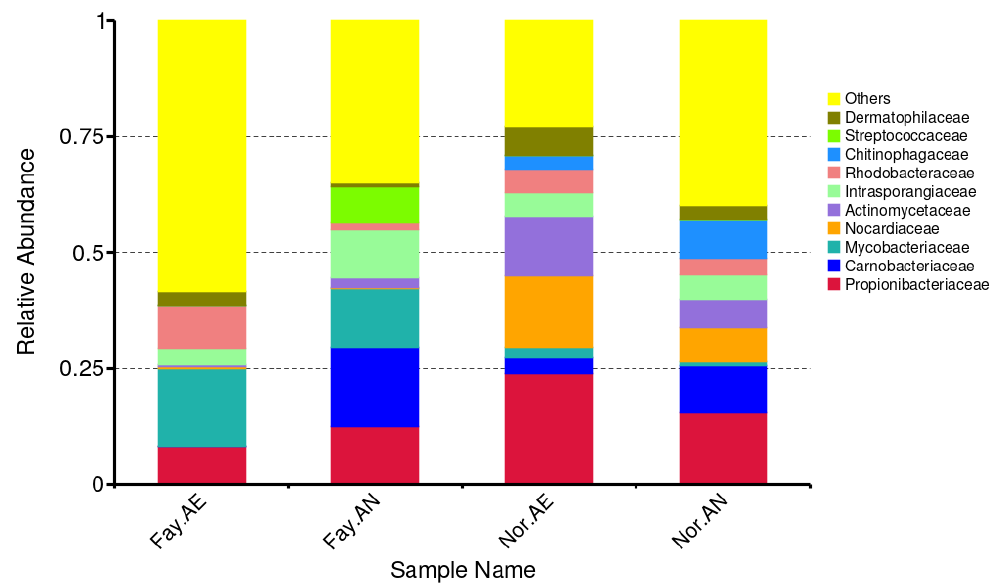
Figure 10. Taxonomy distribution at the family level for Fayetteville sludge from the aerobic (Fay-AE) and anoxic (Fay-AN) tanks and Norman sludge from the aerobic (Nor-AE) and anoxic (Nor-AN) tanks. The histogram shows only the abundance of the top 10 families. The other species are combined into “ Others ” in the Figure.